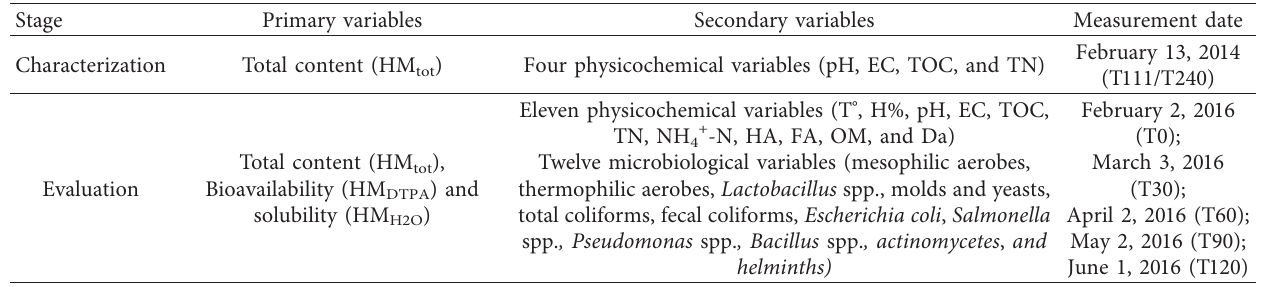
Table 6: Recorded parameters and measurement dates for each stage of the